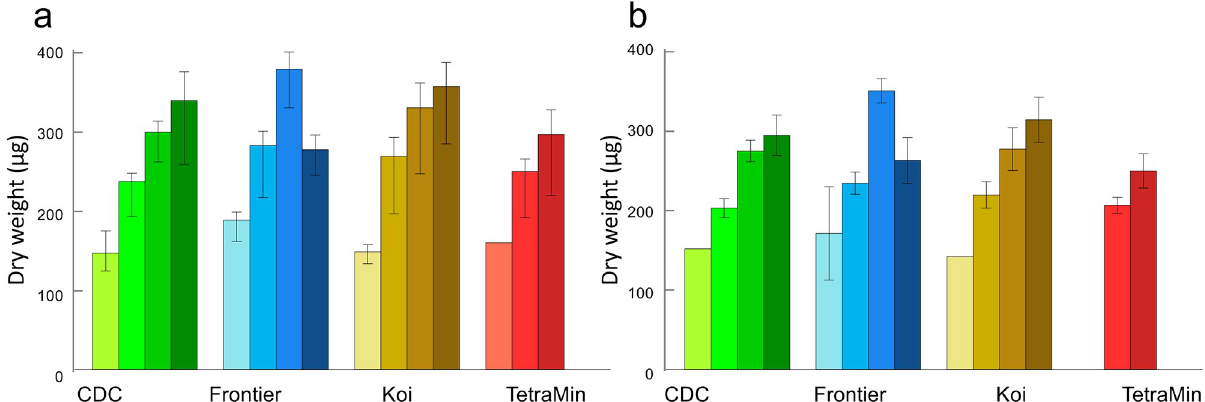
Fig 6. Anopheles gambiae dry weights. (a) Anopheles gambiae females and (b) males. Darker shades of color indicate increasing diet levels of 8, 16, 32 and 64 mg. Error bars are 95% confidence intervals of the mean.